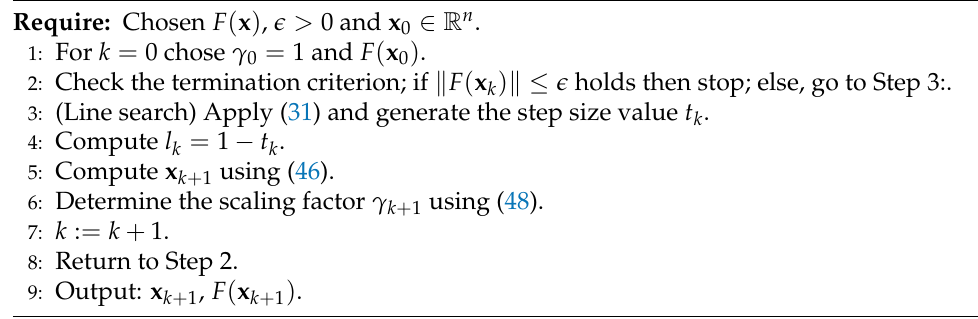
Algorithm 4 The ADSSN iteration based on (46) and